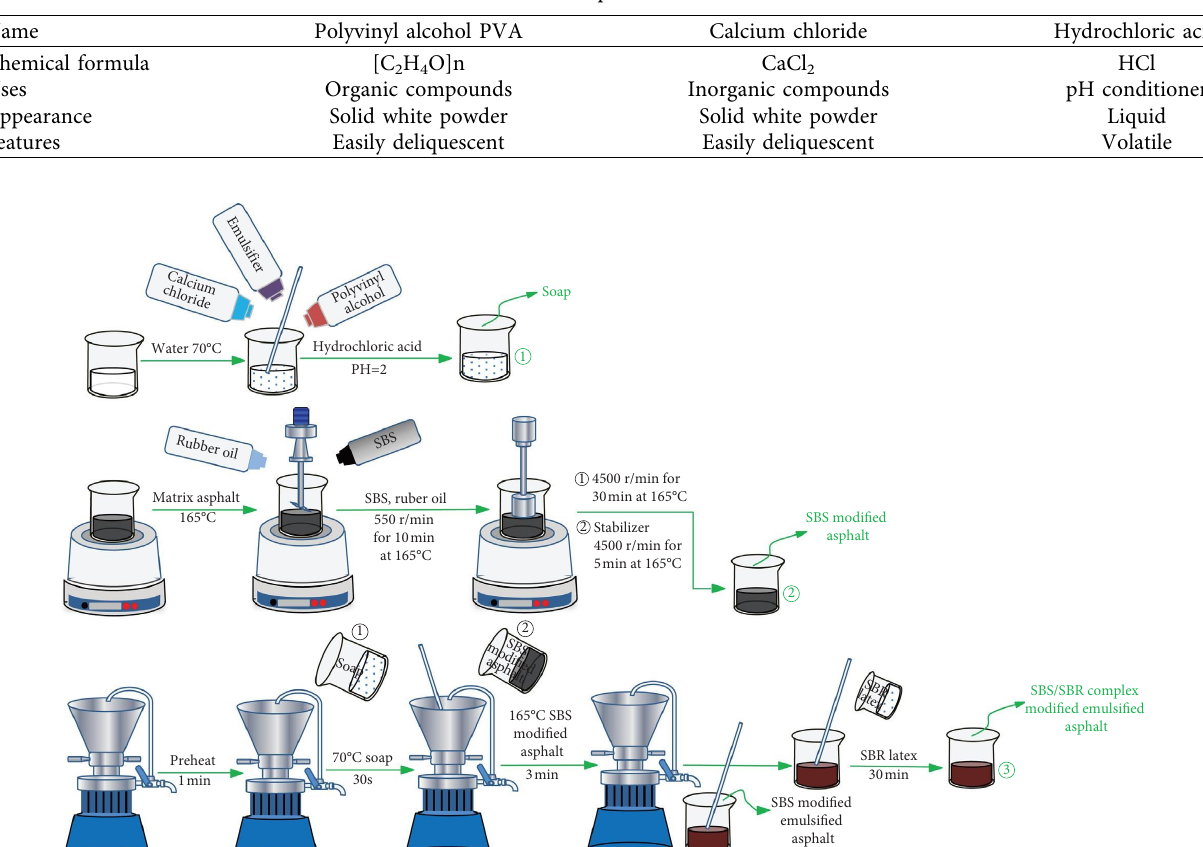
Table 5: Performance parameters of additives.